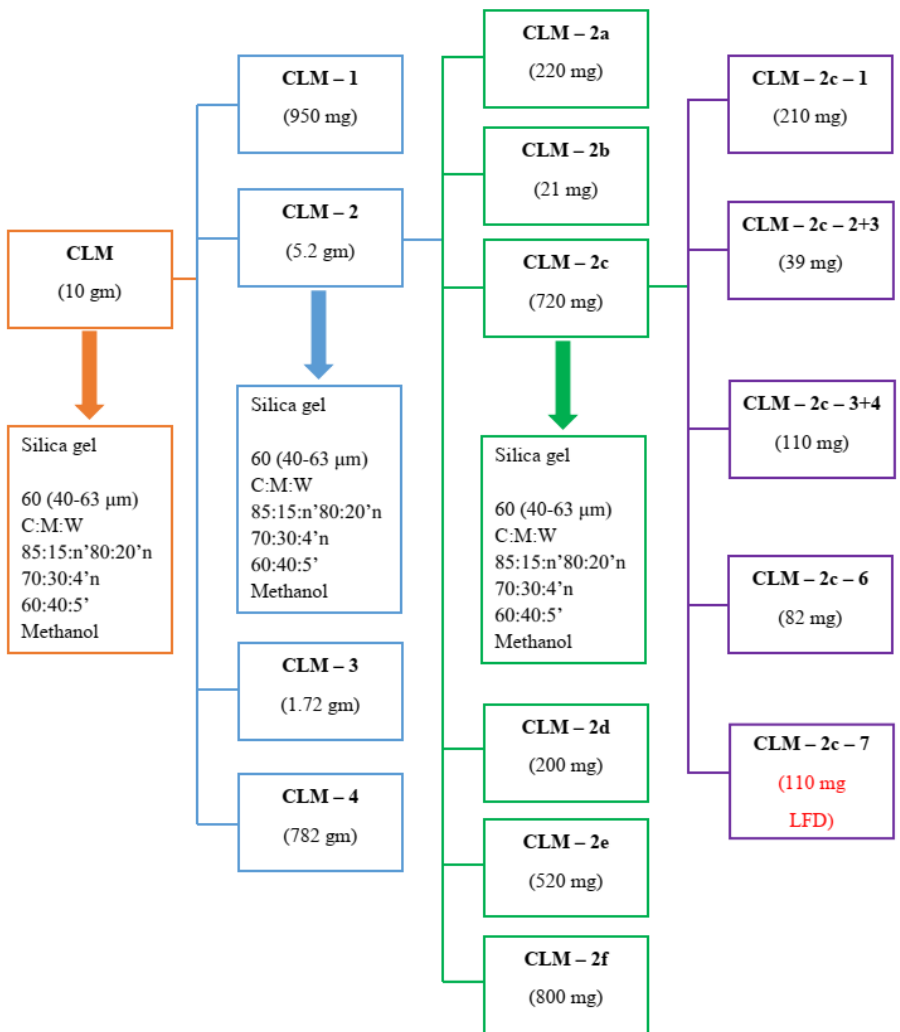
Figure 1. LFD isolation from C. lancifolius methanol extract.